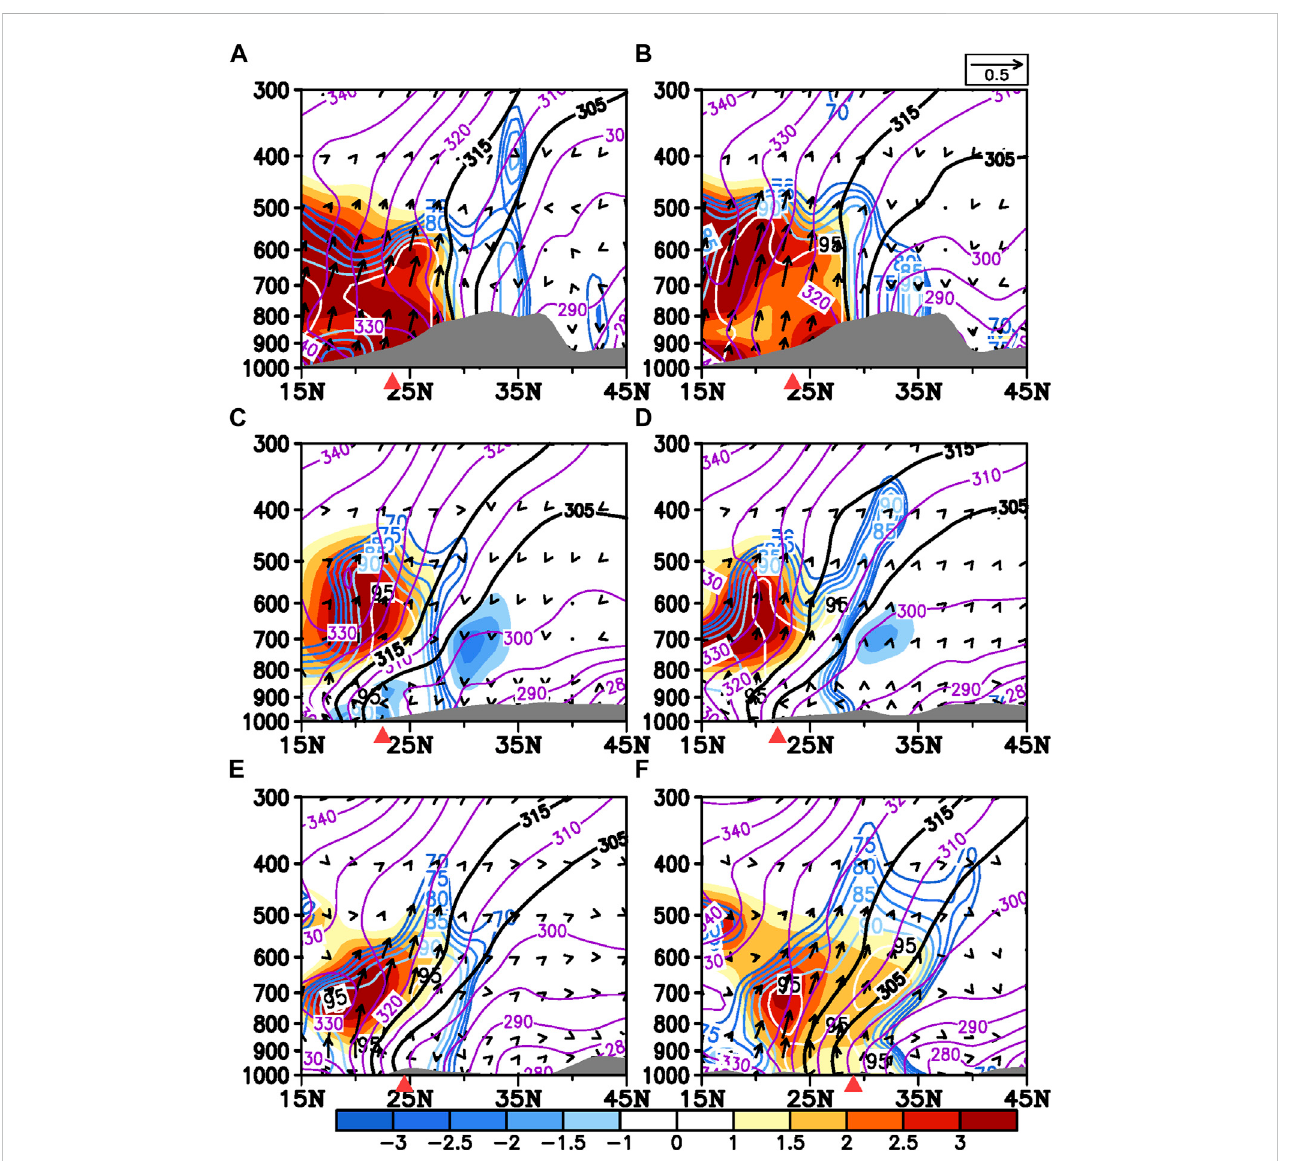
FIGURE 11 Verticalcross-sectionsalongthereddottedlines inFigure7forthewatervapor fl ux(vectors;units: kg m − 1 · s − 1 ),thespeci fi chumidityanomalies(shading; units: kg kg − 1 ), the relative humidity (colored contours; units: %), the equivalent potential temperature (purple contour; units: K) along (A) 100 ° E on January 8, (B) 100 ° E on January 9, (C) 107 ° E on January 10, (D) 110 ° E on January 11, (E) 115 ° E on January 12 and (F) 120 ° E on January 13 in 2015. The latitude with the maximum center of daily precipitation is represented by the red triangle. The thick black lines represent the isolines of the equivalent potential temperature at 305 and 315 K. The gray shading shows the shape of the